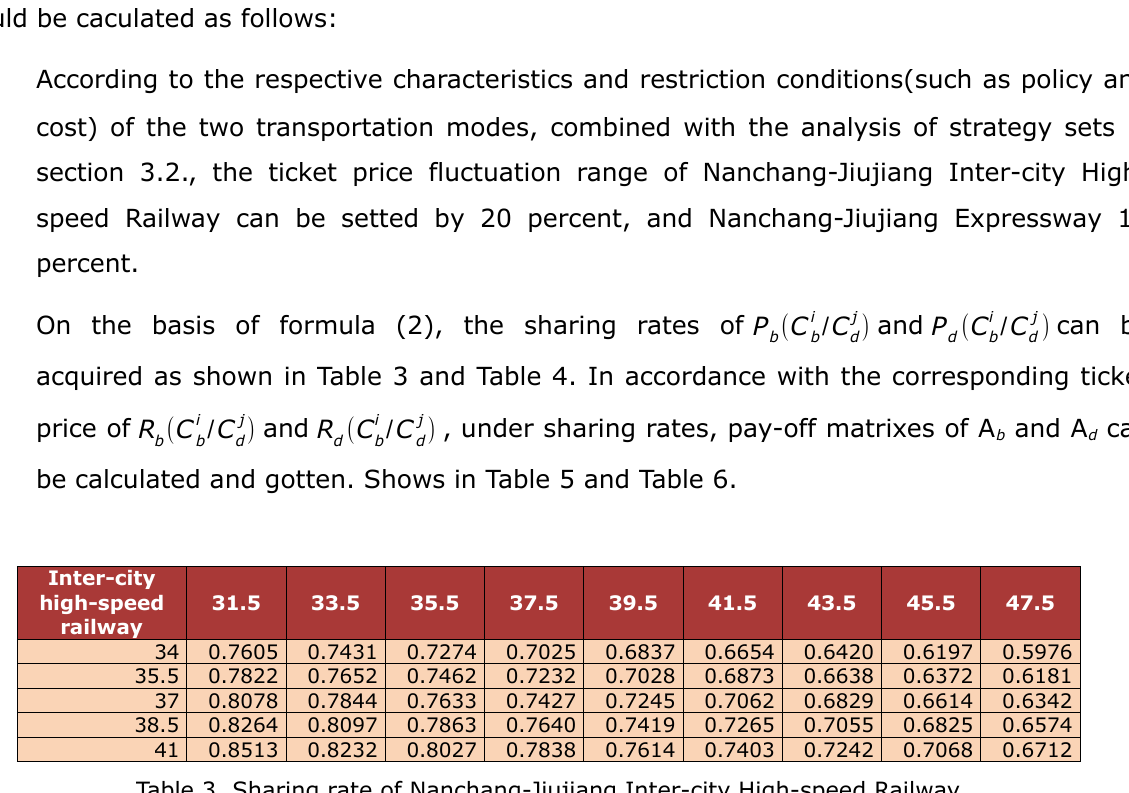
Table 3. Sharing rate of Nanchang-Jiujiang Inter-city High-speed Railway